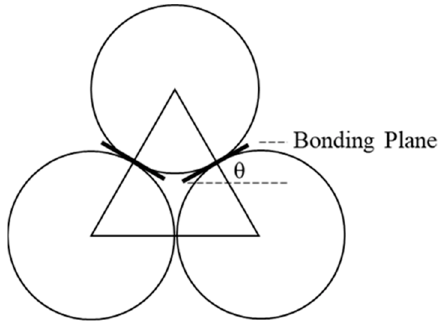
Figure 7. Bonding Plane in Basic Mechanical Unit of HCP Ball Array.